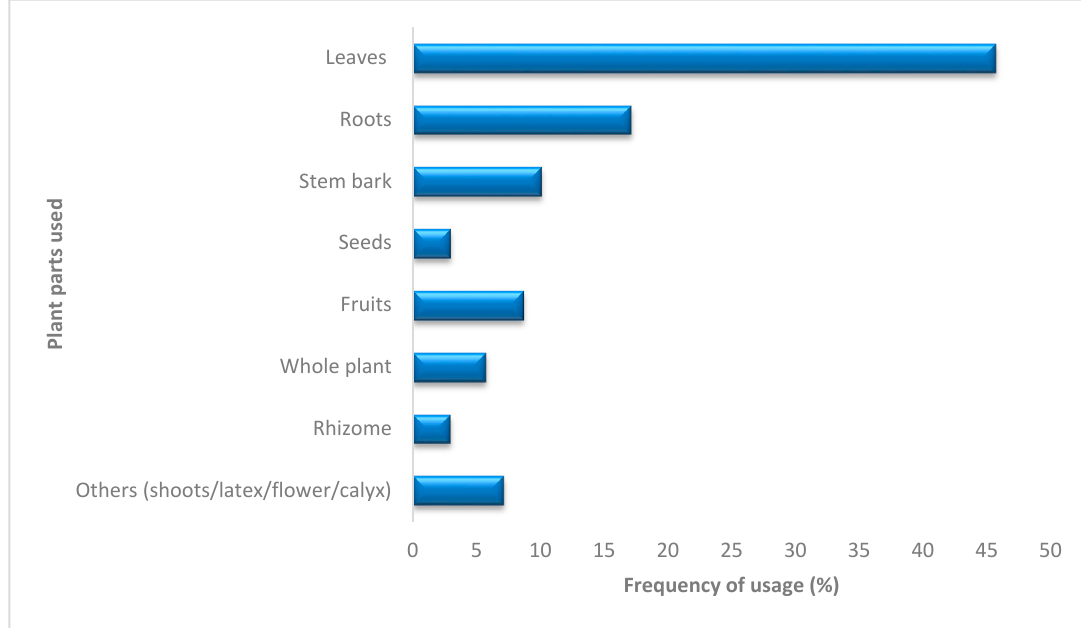
Figure 2. Frequency of plant parts used as antidotes.